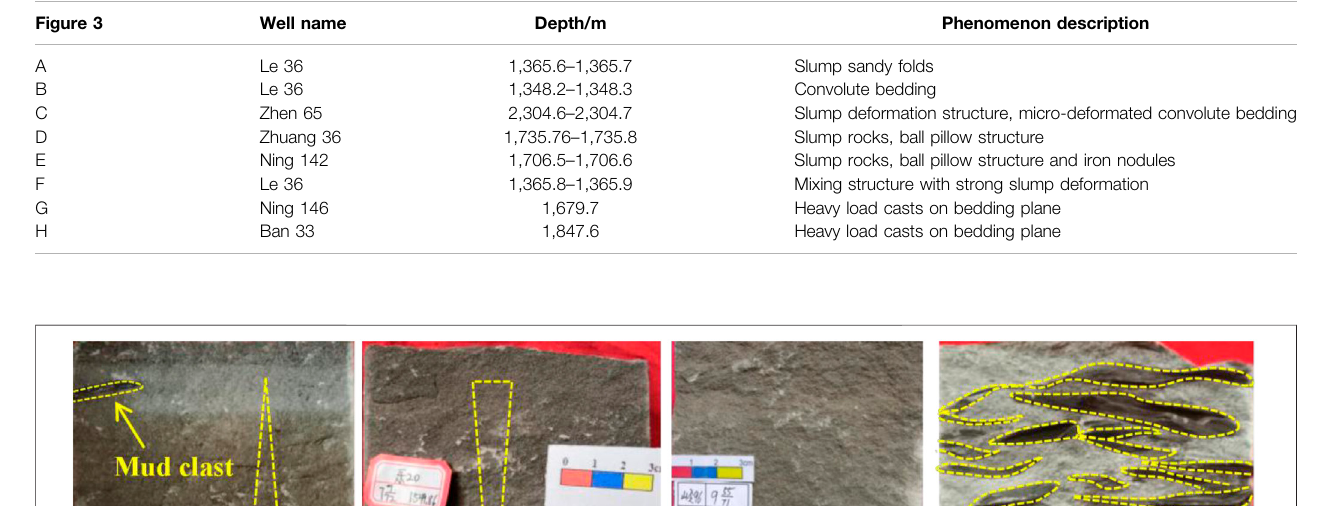
TABLE 6 | The well name, depth, and phenomenon description of Figure 5 . See Figure 1 for the locations of wells.